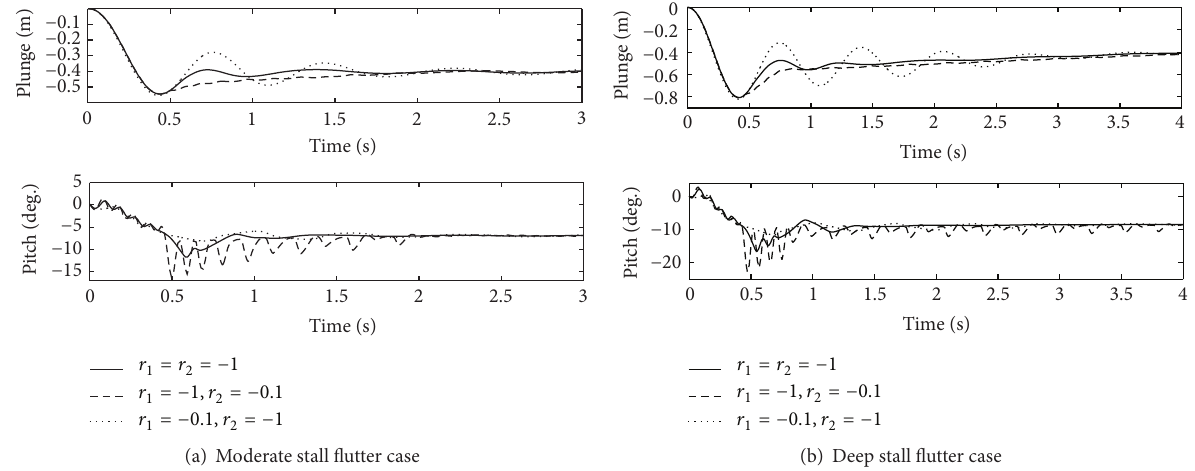
Figure 13: Adaptive stall flutter control responses with different control strategies for (a) moderate stall flutter case and (b) deep stall flutter case.